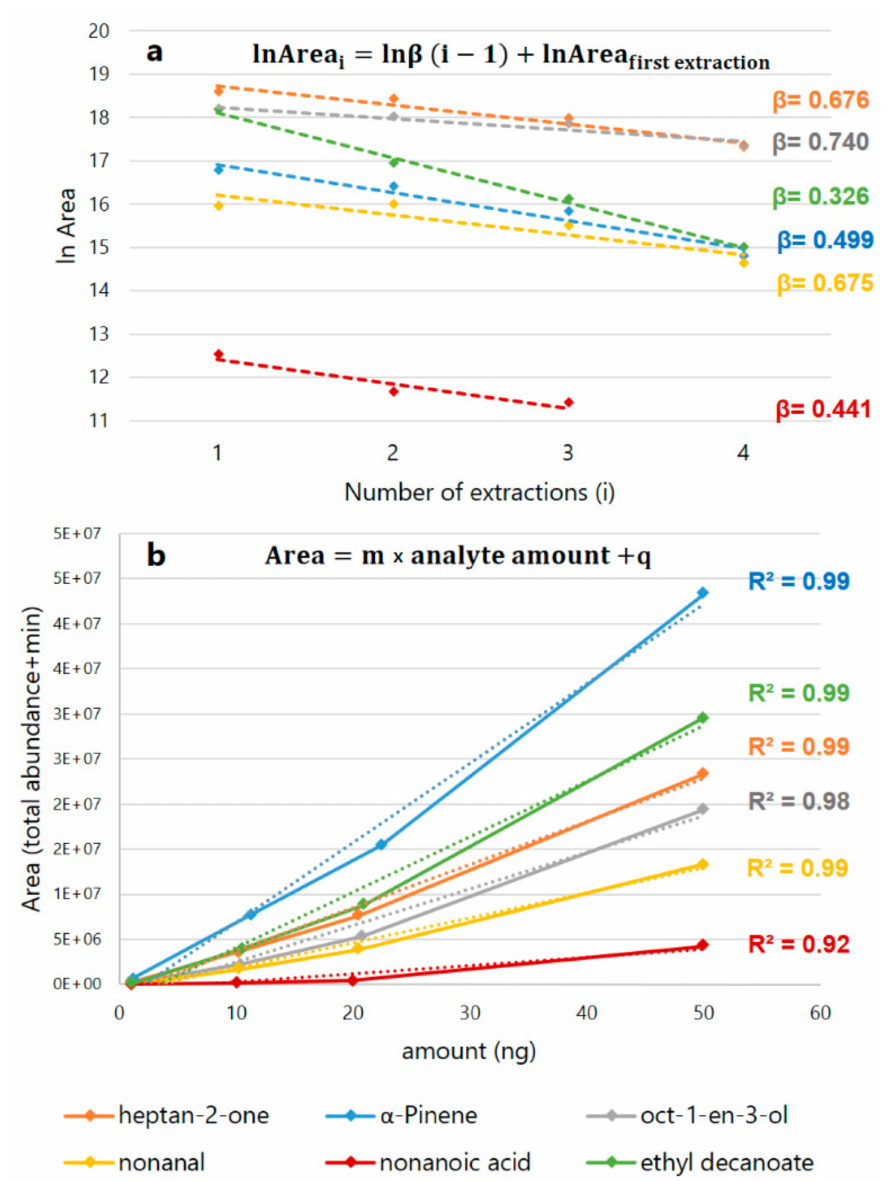
Figure 1. Linear regression plots employed in the determination of β values for each target compound, by means of the multiple extractions technique on calibration mixtures ( a ), and to the estimation of analytes’ total areas in samples, by mean of liquid injections of four di ff erent concentrations of calibration mixtures ( b ) (numerical data are shown in Table